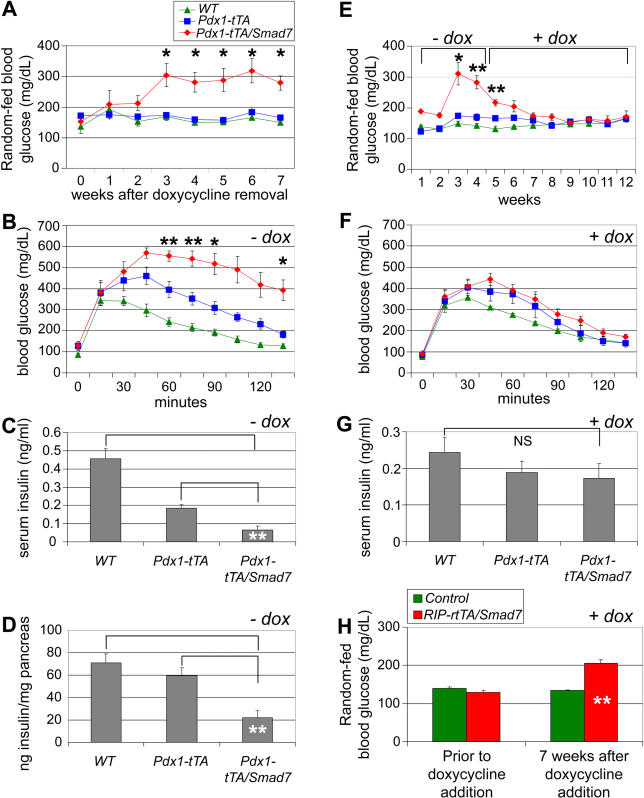
Diabetes and Reduced Pancreatic Insulin Production following Smad7 Expression in Pancreatic β CellsData are presented as the average ± SEM. Data are from ten litters with at least four mice per genotype.
p-Values and statistical significance in (A–G) reflects comparison of bitransgenic mice to
Pdx1-tTA controls, unless otherwise indicated.
(A) Random-fed blood glucose levels of male mice with indicated genotypes. Similar data were obtained for female littermates (unpublished data).(B) Intraperitoneal glucose challenge of male mice (8–10 wk old) with the indicated genotypes after a 14-h overnight fast.(C) Serum insulin from male mice with the indicated genotypes during random feeding. Mice were 8–10 wk old.(D) Total pancreatic insulin levels in 10- to 12-wk-old mice with the indicated genotypes. Insulin levels are expressed as ng/mg pancreas protein.(E–G) Reversal of overt diabetes mellitus and impaired insulin levels by treating bitransgenic
Pdx1-tTA/Smad7 mice with doxycycline.
(E) Blood glucose levels during random feeding following exposure of mice with indicated genotypes and ages (weeks after birth) to doxycyline.(F) Intraperitoneal glucose challenge following a 14-h overnight fast in 12- to 14-wk-old mice with the indicated genotypes after 5 wk of continuous doxycycline exposure.(G) Serum insulin during random feeding from 12- to 14-wk-old mice with the indicated genotypes after 5 wk of continuous doxycycline exposure.(H) Induction of Smad7 by doxycycline in insulin
+ cells using
RIP-rtTA/Smad7 animals also yields mice with elevated levels of random-fed blood glucose.
For all panels: *
p < 0.05; **
p < 0.01.